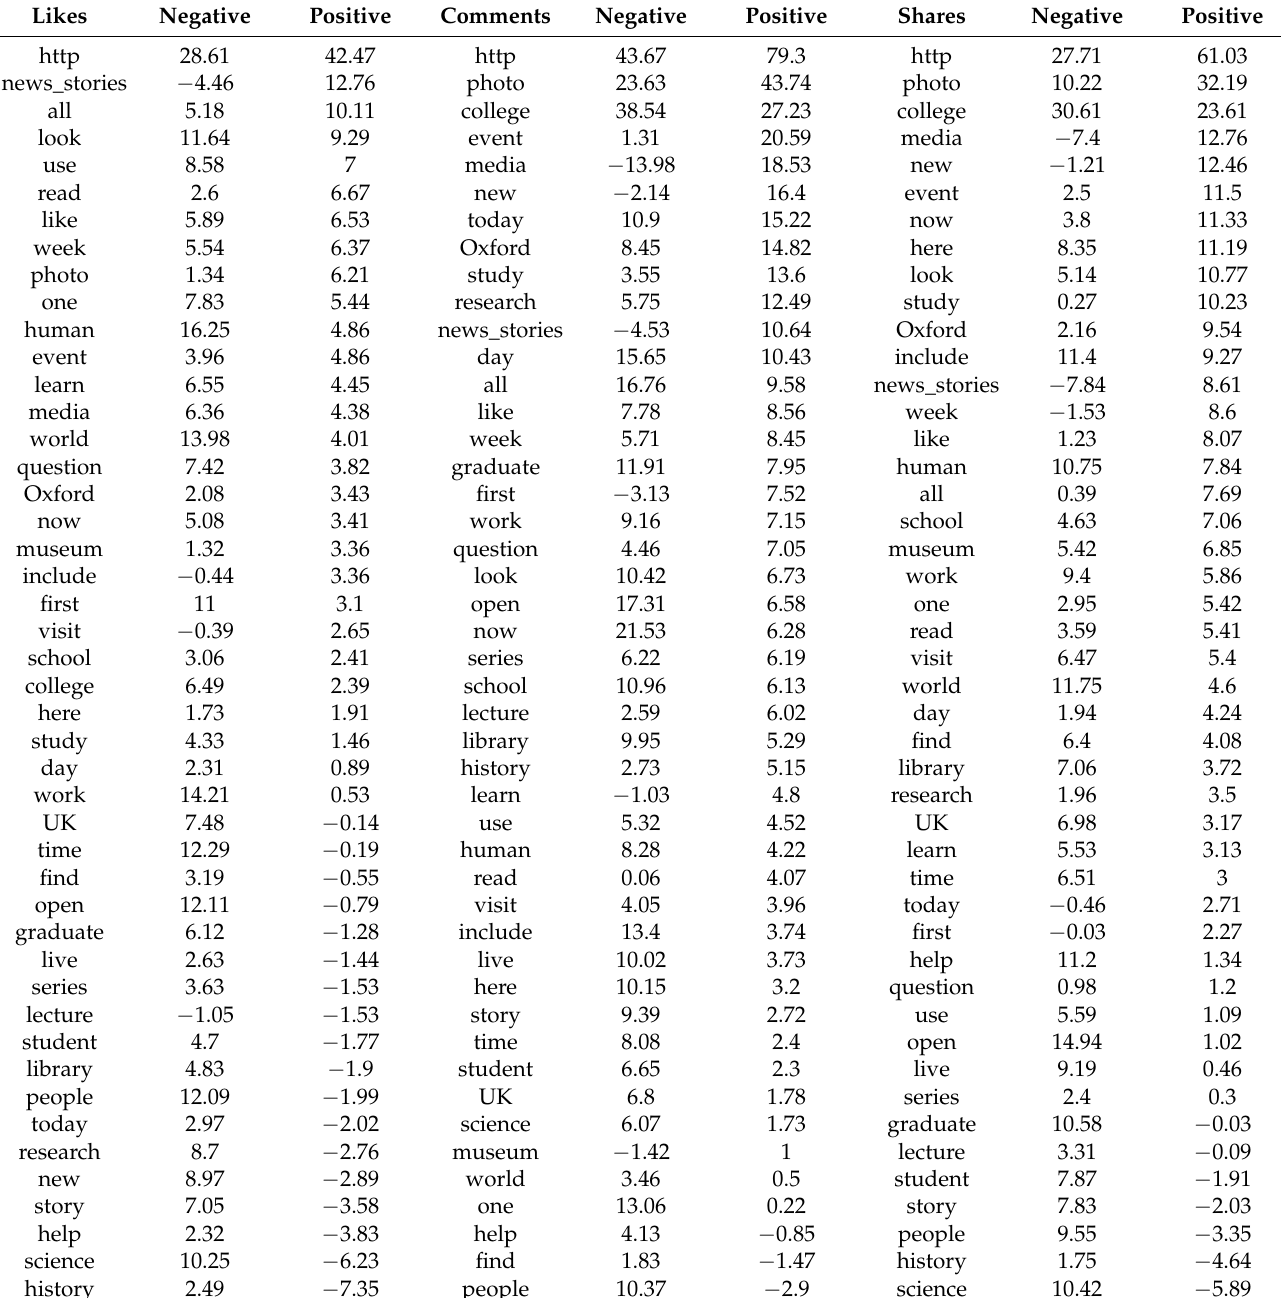
Table A4. Negative and positive clues (University of